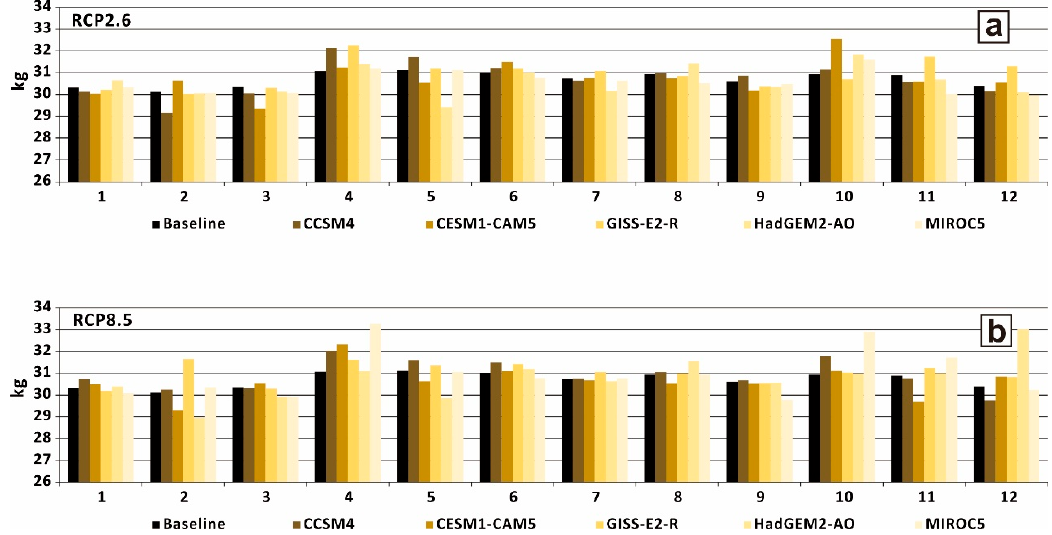
Figure 6. The average monthly N export under di ff erent climate change scenarios ( a ) RCP2.6 and ( b ) RCP8.5. Note: Numbered months along